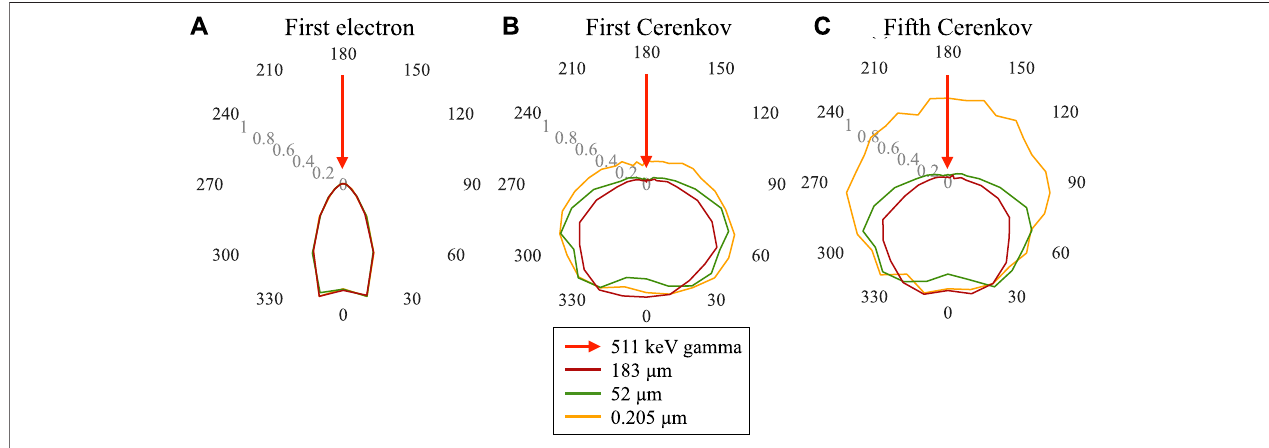
FIGURE 6 | Polar plots of the normalized distribution of the (A) fi rst electron (B) fi rst and (C) fi fth emitted Cerenkov photon momentum with respect to the incident gamma direction, projected on the x-z plane according to Figure 1 , for three representative values of the electron mean step length. The 0 – 1 scale represents the magnitude of the polar plot.